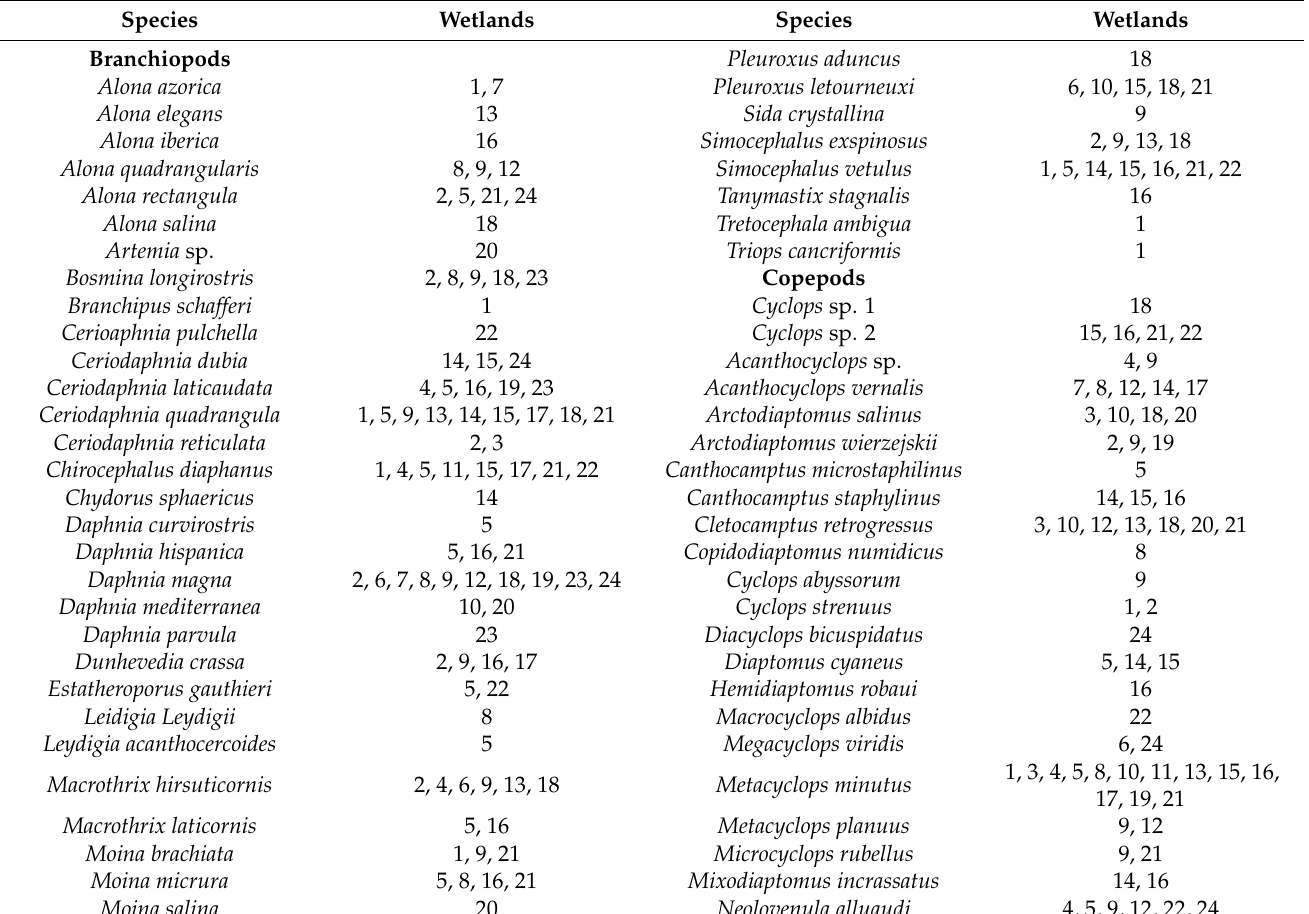
Table 1. Zooplankton species in the studied wetlands. Wetlands are coded according to the caption of Figure